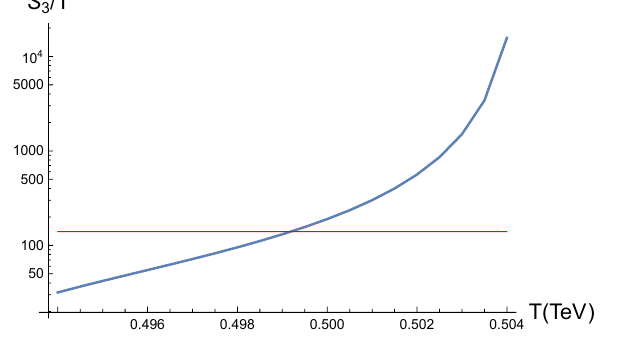
Figure 7 . Bounce action S 3 /T dependence on the temperature (blue line) computed using the package FindBounce [63]. The tunneling rate starts dominating over expansion at S 3 /T ' 140 (red